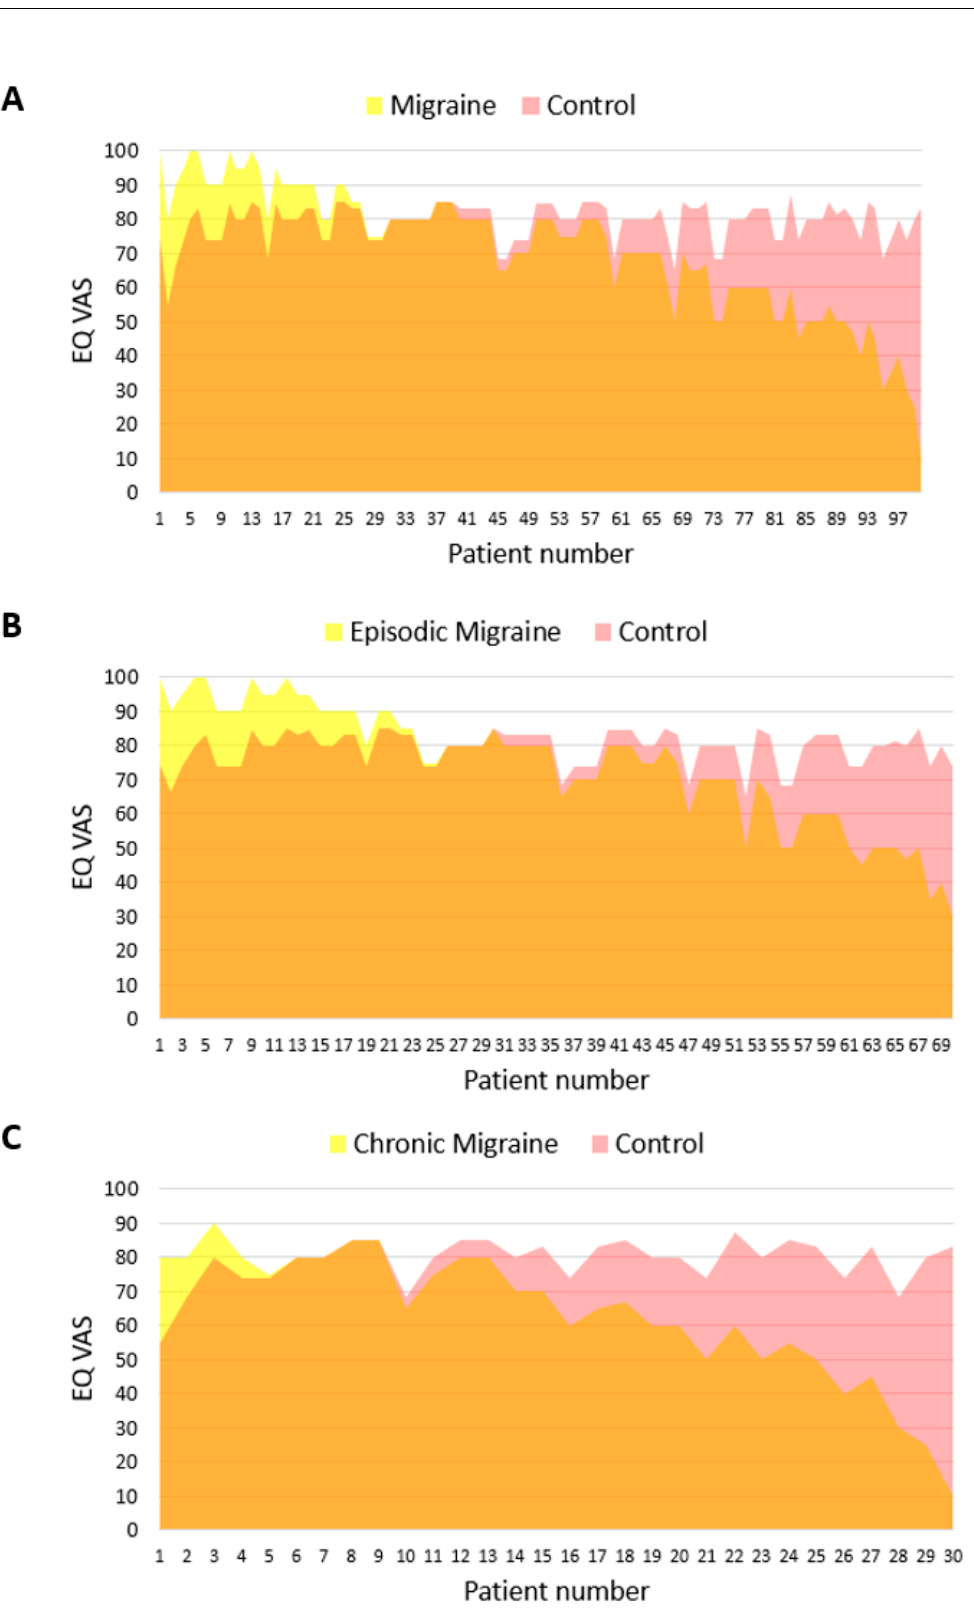
Figure 3. The burden of ( A ) migraine, ( B ) episodic migraine and ( C ) chronic migraine according to the EQ VAS. Pink color denotes the quality of life lost due to the disease in comparison to controls from the general population.